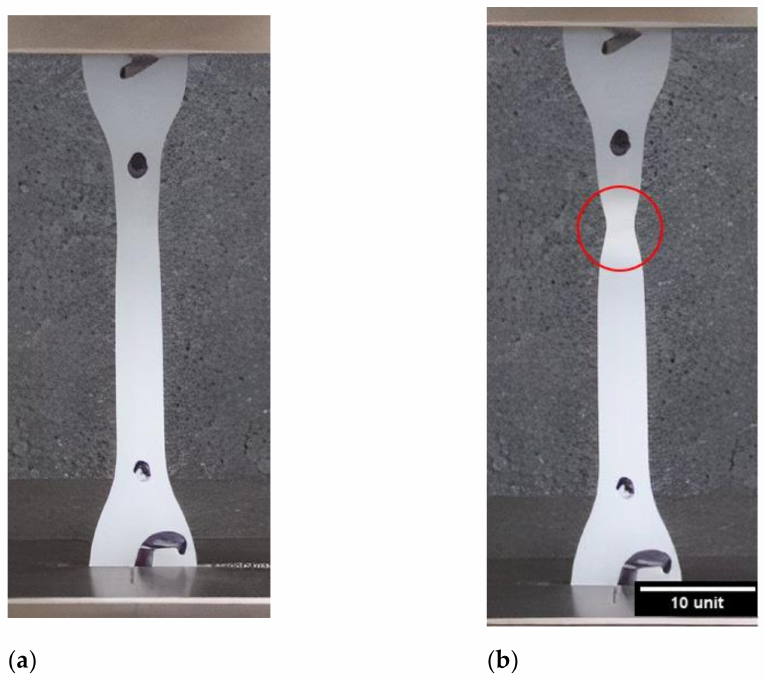
Figure 3. ( a ) Initial state of the tested sample, ( b ) start of the necking phenomenon during tensile